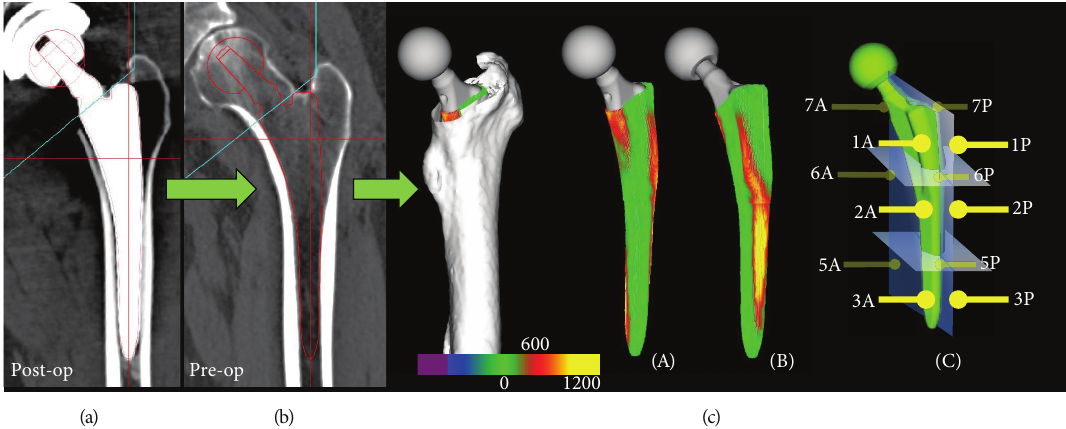
Figure2:VirtualimplantmodelgeneratedfromCADdata(a)andalignedandfittedtothecontouroftherealprostheticstempostoperatively. The virtual model was aligned in the same position with a preoperative CT image (b). The contact pattern images were three-dimensionally visualized using a color map based on the CT values around the stem (c). The stem was defined as being in contact with the cortical bone if the CT value around the stem was ≥ 600HU. Red color indicates 600 HU and yellow color indicates 1200 HU. (A) Anteromedial view. (B) Anterolateral view. (C) Modified Gruen zone classification; for example, zone 2A/zone 2P indicates the anterior/posterior portion of zone